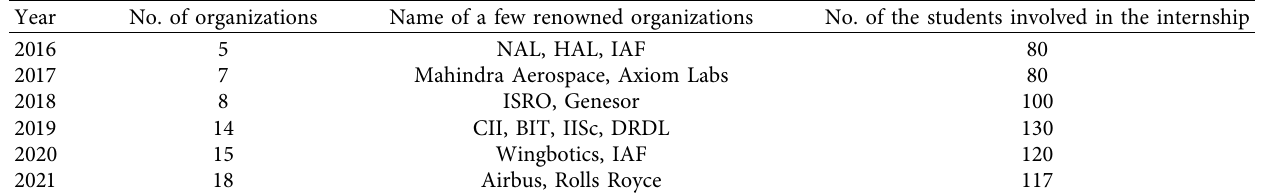
Table 4: Internship data.